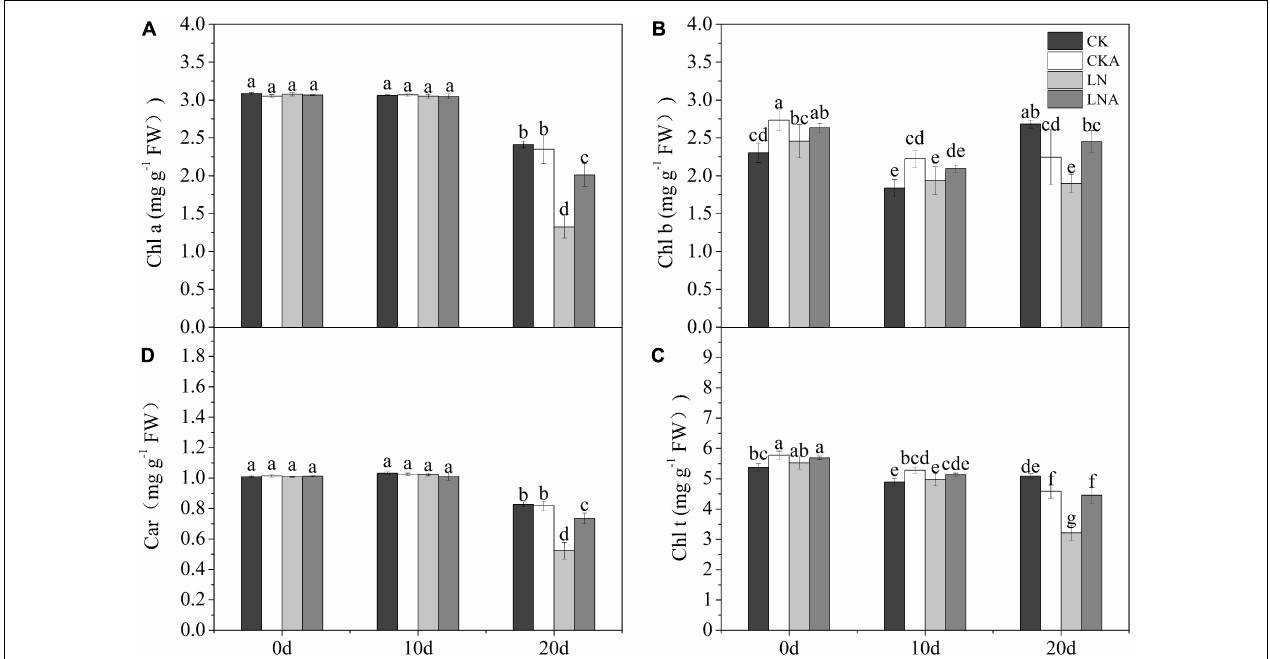
FIGURE 6 | Analysis of chlorophyll. Chlorophyll a (A) , chlorophyll b (B) , total chlorophyll (C) , and carotenoids (D) . Values are means of five replicates ± SD. Values not represented by the same letter are significantly different according to Tukey’s multiple-range test ( P < 0.05).